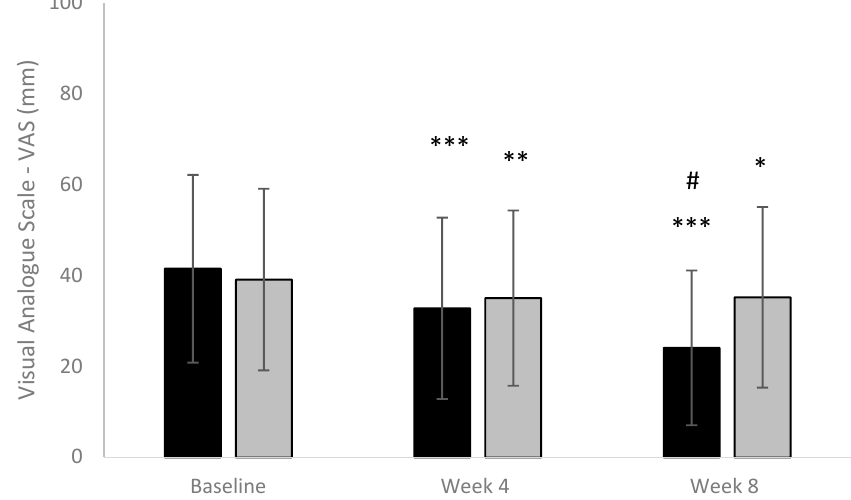
Figure 3. Visual Analogue Scale (VAS) for pain. (Black column: active; Grey column: placebo). * p < 0.05 vs. baseline; ** p < 0.01 vs. baseline; *** p < 0.001 vs. baseline; # p < 0.05 active vs. baseline.